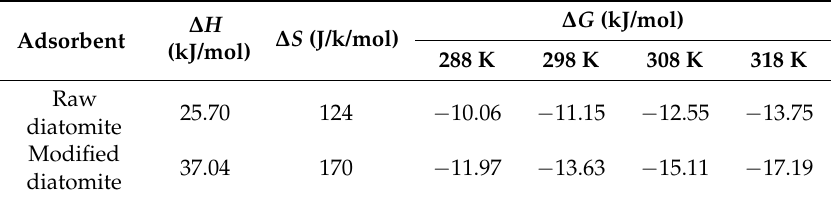
Table 2. Thermodynamic parameters for raw and modified Diatomite adsorption of 1-naphthol. ∆ G (kJ/mol) ∆ H ∆ S (J/k/mol) Adsorbent (kJ/mol) 288 K 298 K 308 K 318 K Raw 25.70 − 13.75 diatomite Modified 37.04 170 − 11.97 − diatomite